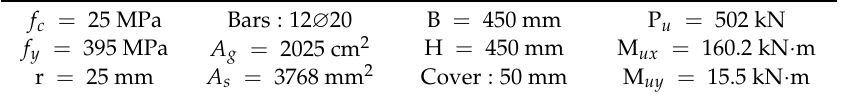
Table 5. Specifications of FRP jacketing sheets used in the case study.